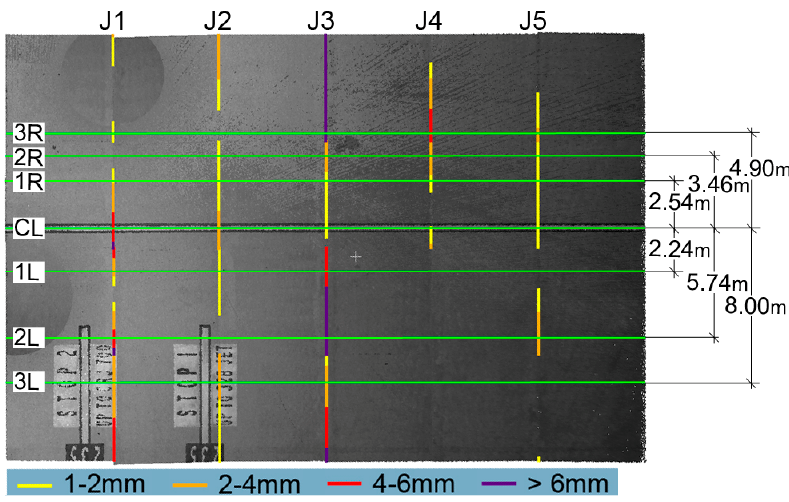
Figure 9. Left panel: graphical display of the linear sections of the joints perpendicular to the airplane path where the faulting values fall between certain values (shown in the legend). Table 5. Faulting values evaluated in correspondence of the joints.